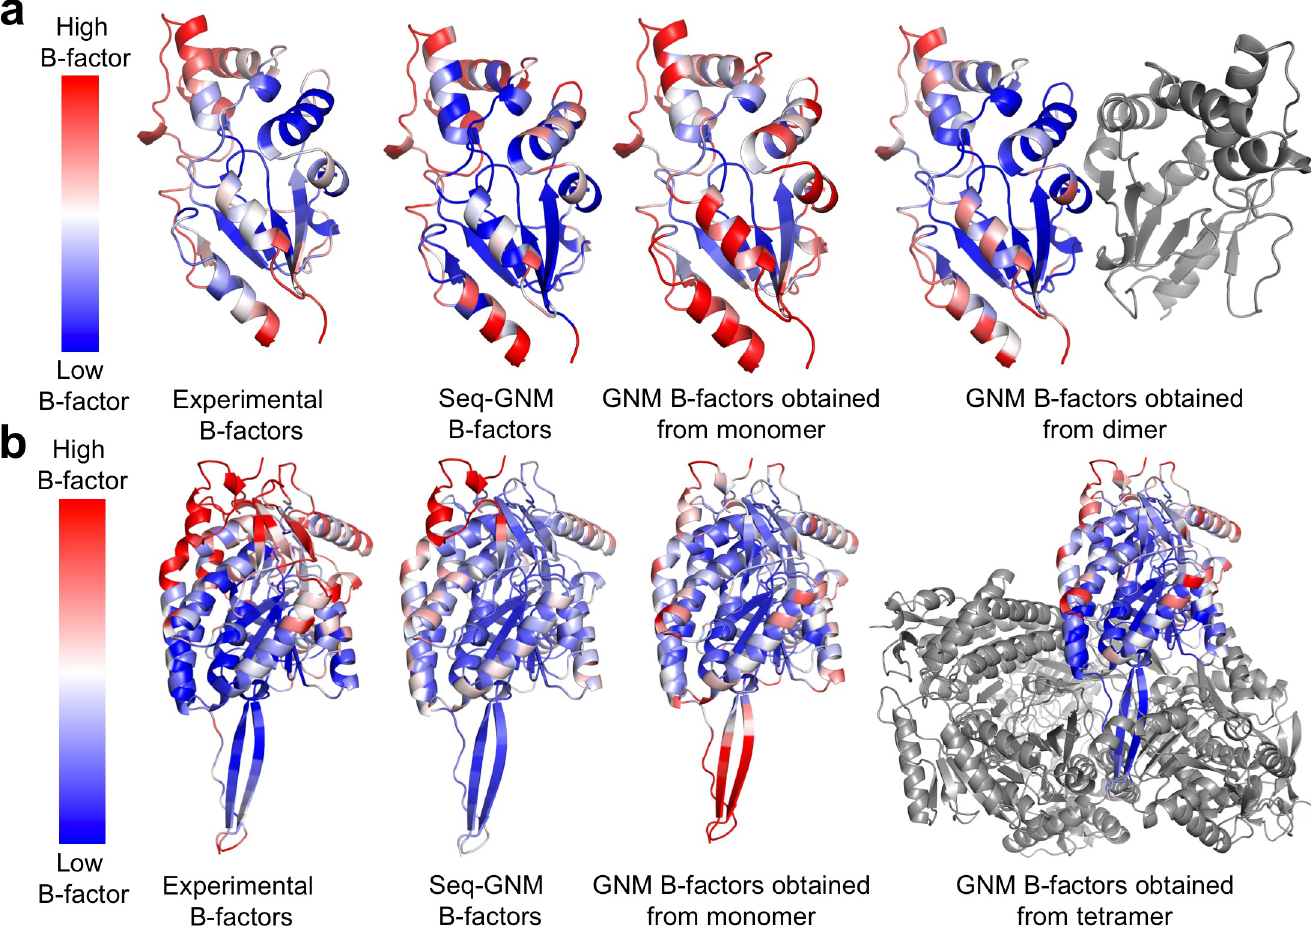
Fig 4. Comparison of B-factors obtained from experiments, Seq-GNM, GNM from monomeric structure, and GNM from oligomeric structure. B-factors are shown on the respective structures for (a) 5’(3’)-deoxyribonucleotidase (2JAO) and (b) Aldehyde Dehydrogenase 7A1 (2J6L). (a) The correlation of Seq-GNM to experimental B-factors is 0.83 while correlation of GNM B-factors obtained from monomer to experimental B-factors is 0.63. When dimer a is used for GNM analysis the correlation of GNM B-factors obtained from monomer to experimental B-factors increased to 0.72. (b) The correlation of Seq-GNM to experimental B-factors is 0.61 while correlation of GNM B-factors obtained from monomer to experimental B-factors is 0.37. When a tetramer is used for GNM analysis the correlation of GNM B-factors obtained from monomer to experimental B-factors increase to 0.76. The change in correlation for GNM between monomer and oligomer clearly shows the drawback for dependence on the crystal structure of biounits. However, Seq-GNM captures the interface B-factors correctly.